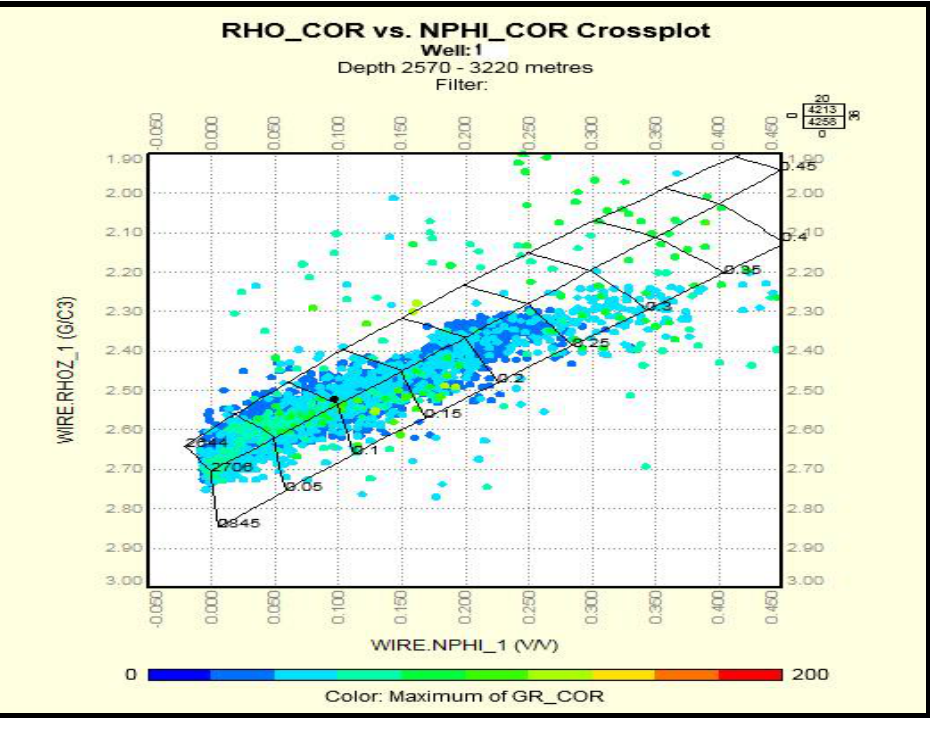
Figure 2. Density-neutron cross plot for well No.1 of Yaran oil field